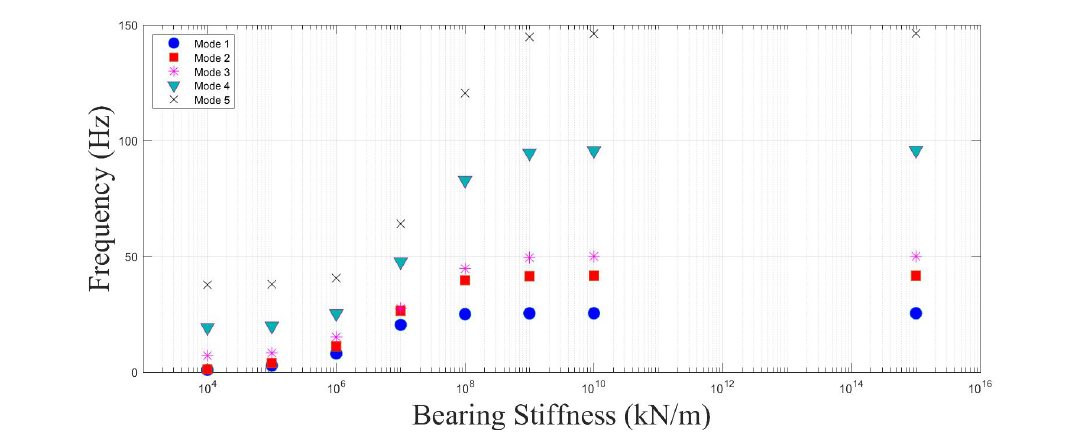
Figure 14. Vibration Frequencies–Three span